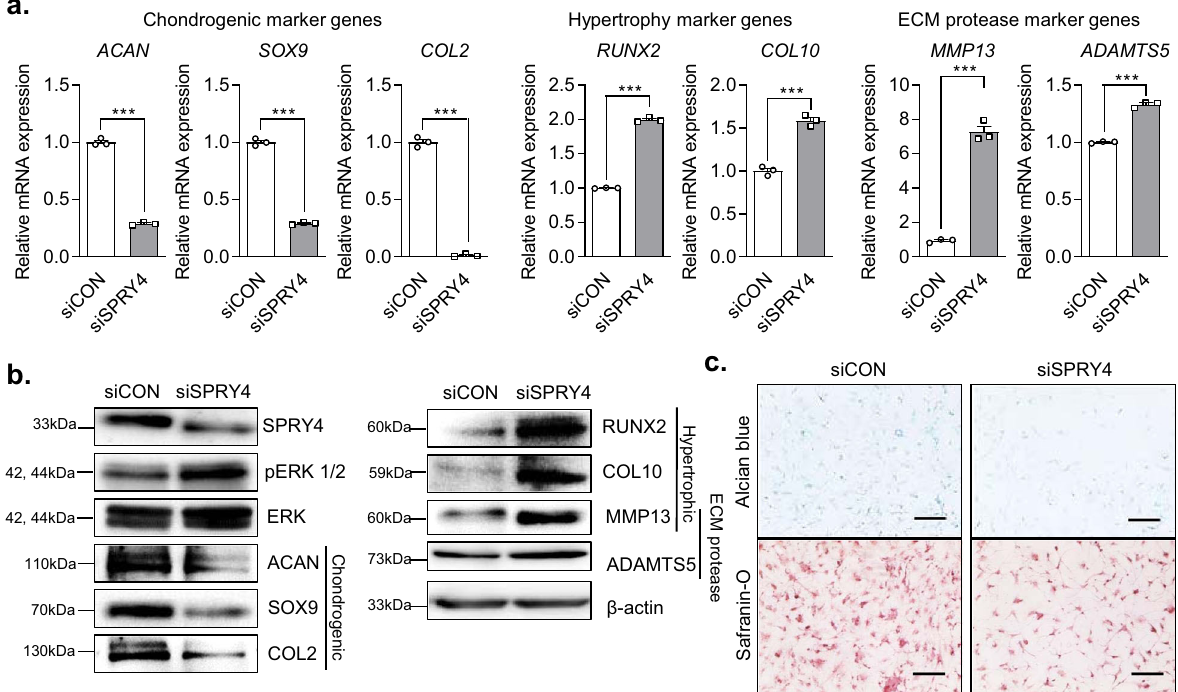
Fig. 3 Effect of SPRY4 suppression on the OA-related biological properties of HCs. a mRNA expression analysis of various chondrogenic, hypertrophic, and ECM protease markers in siCON-treated and siSPRY4-treated HCs. The data represent the mean ± SEM ( n = 3, unpaired t -test with Welch ’ s correction). b Western blot protein analyses of various chondrogenic, hypertrophic, and ECM protease markers in siCON-treated and siSPRY4-treated HCs. c Alcian blue and Safranin-O staining of siCON-treated and siSPRY4-treated HCs. Scare bar, 100 μ